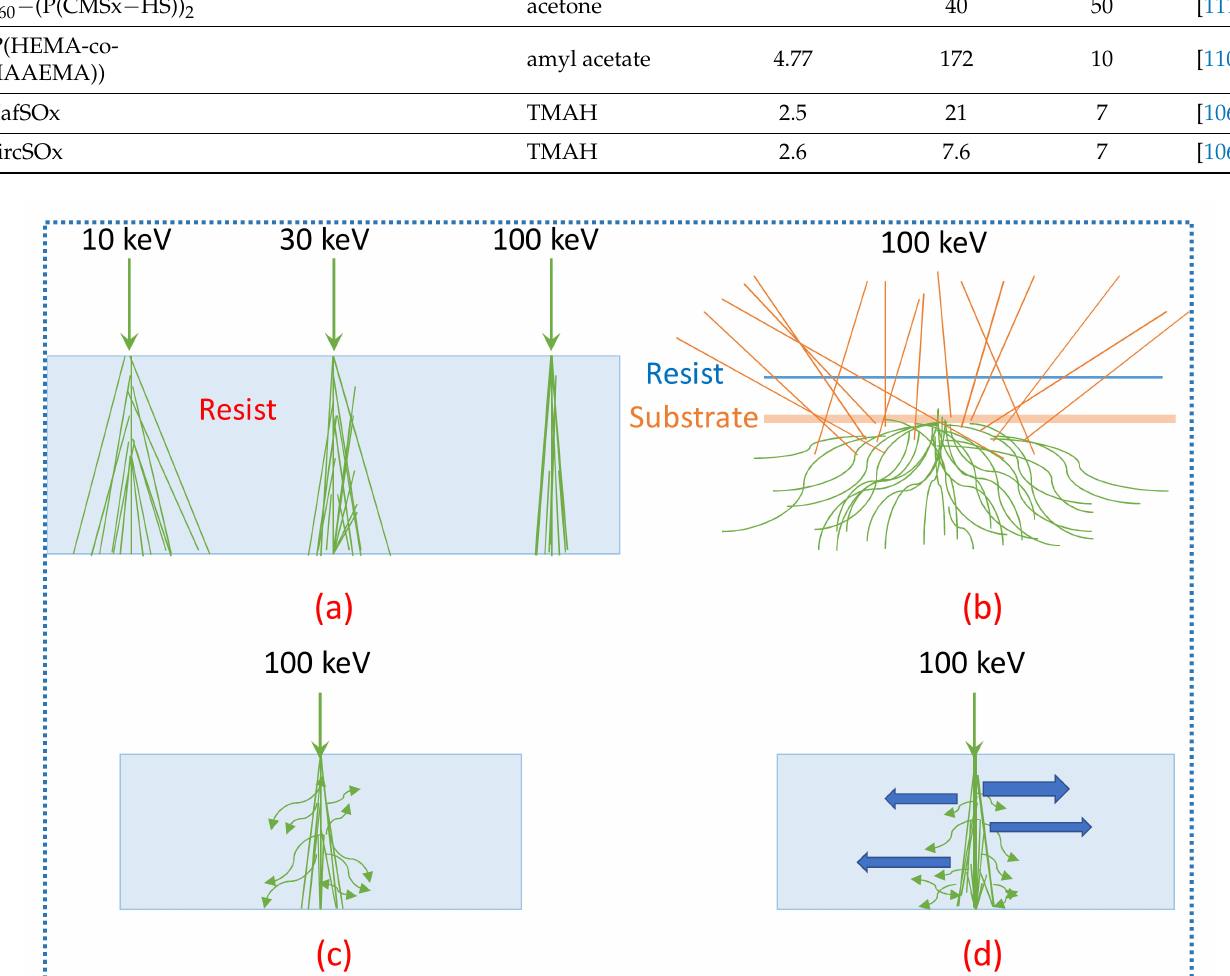
Figure 11. ( a ) Forward scattering, ( b ) backscattering, ( c ) secondary electrons, ( d ) volume plasmons. Scattering is one of the major limitations of EBL technique. Resolution is also limited by secondary electrons having energy in the 2 to 50 eV range [112]. One of the observed effects is volume plasmons as shown in Figure 11d in which some charge waves called volume plasmons move in resist causes alteration in chemical bonds because of the